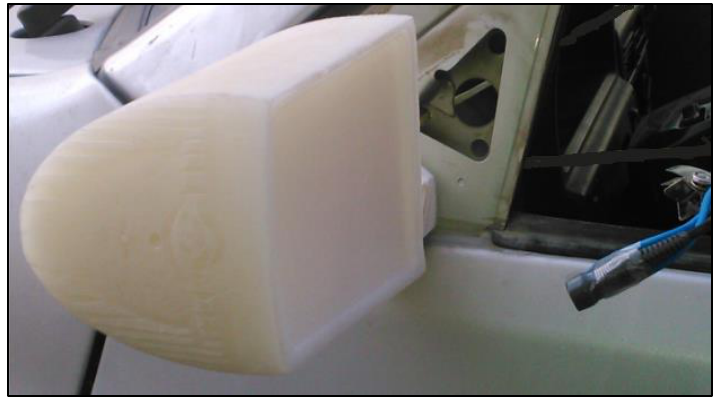
Figure 16. Mounted modified car side mirror on